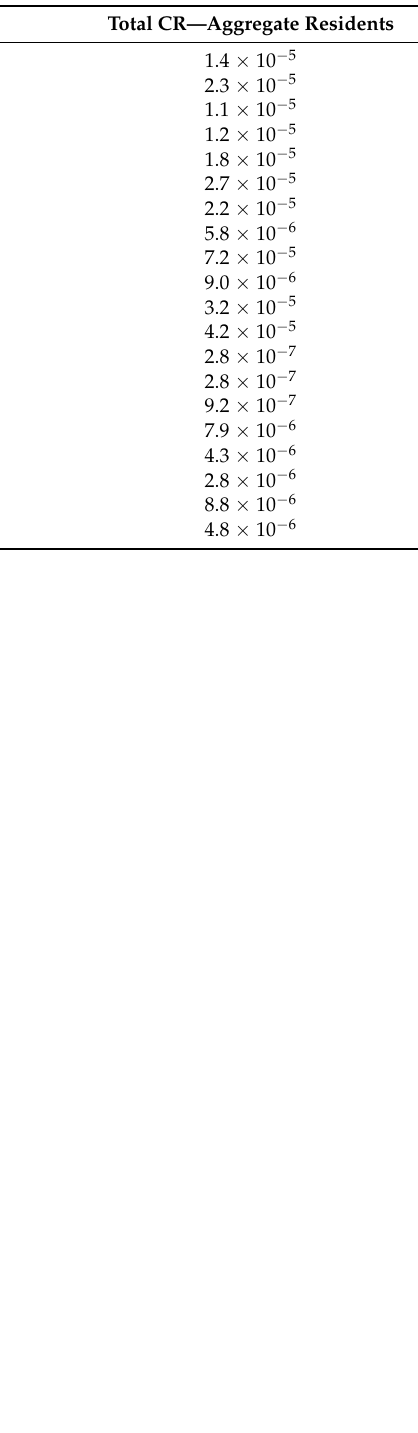
Table 9. Total hazard indices (HIs) and total cancer risks (CRs) in sectors.